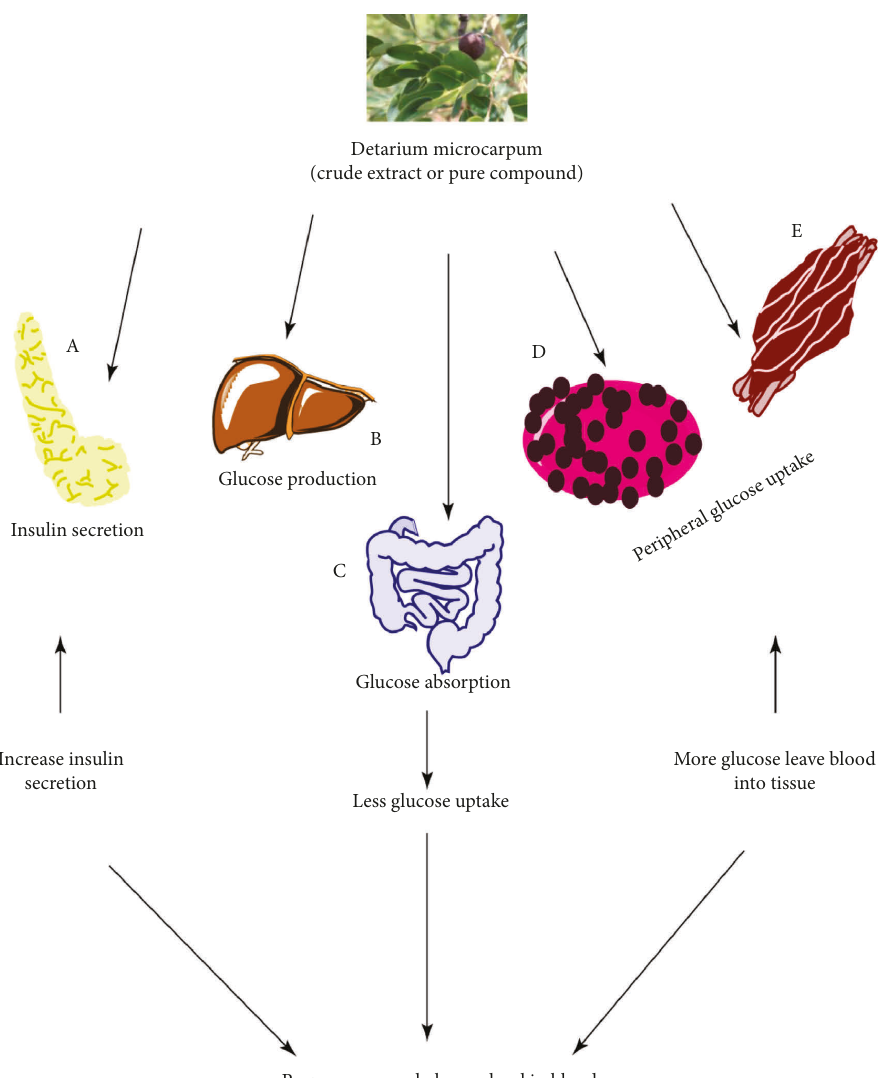
Figure 4: Hypoglycaemic mechanism of Detarium microcarpum and effect on target tissues. A � pancreas; B � liver; C � intestine; D � adipose tissue; and E � muscle